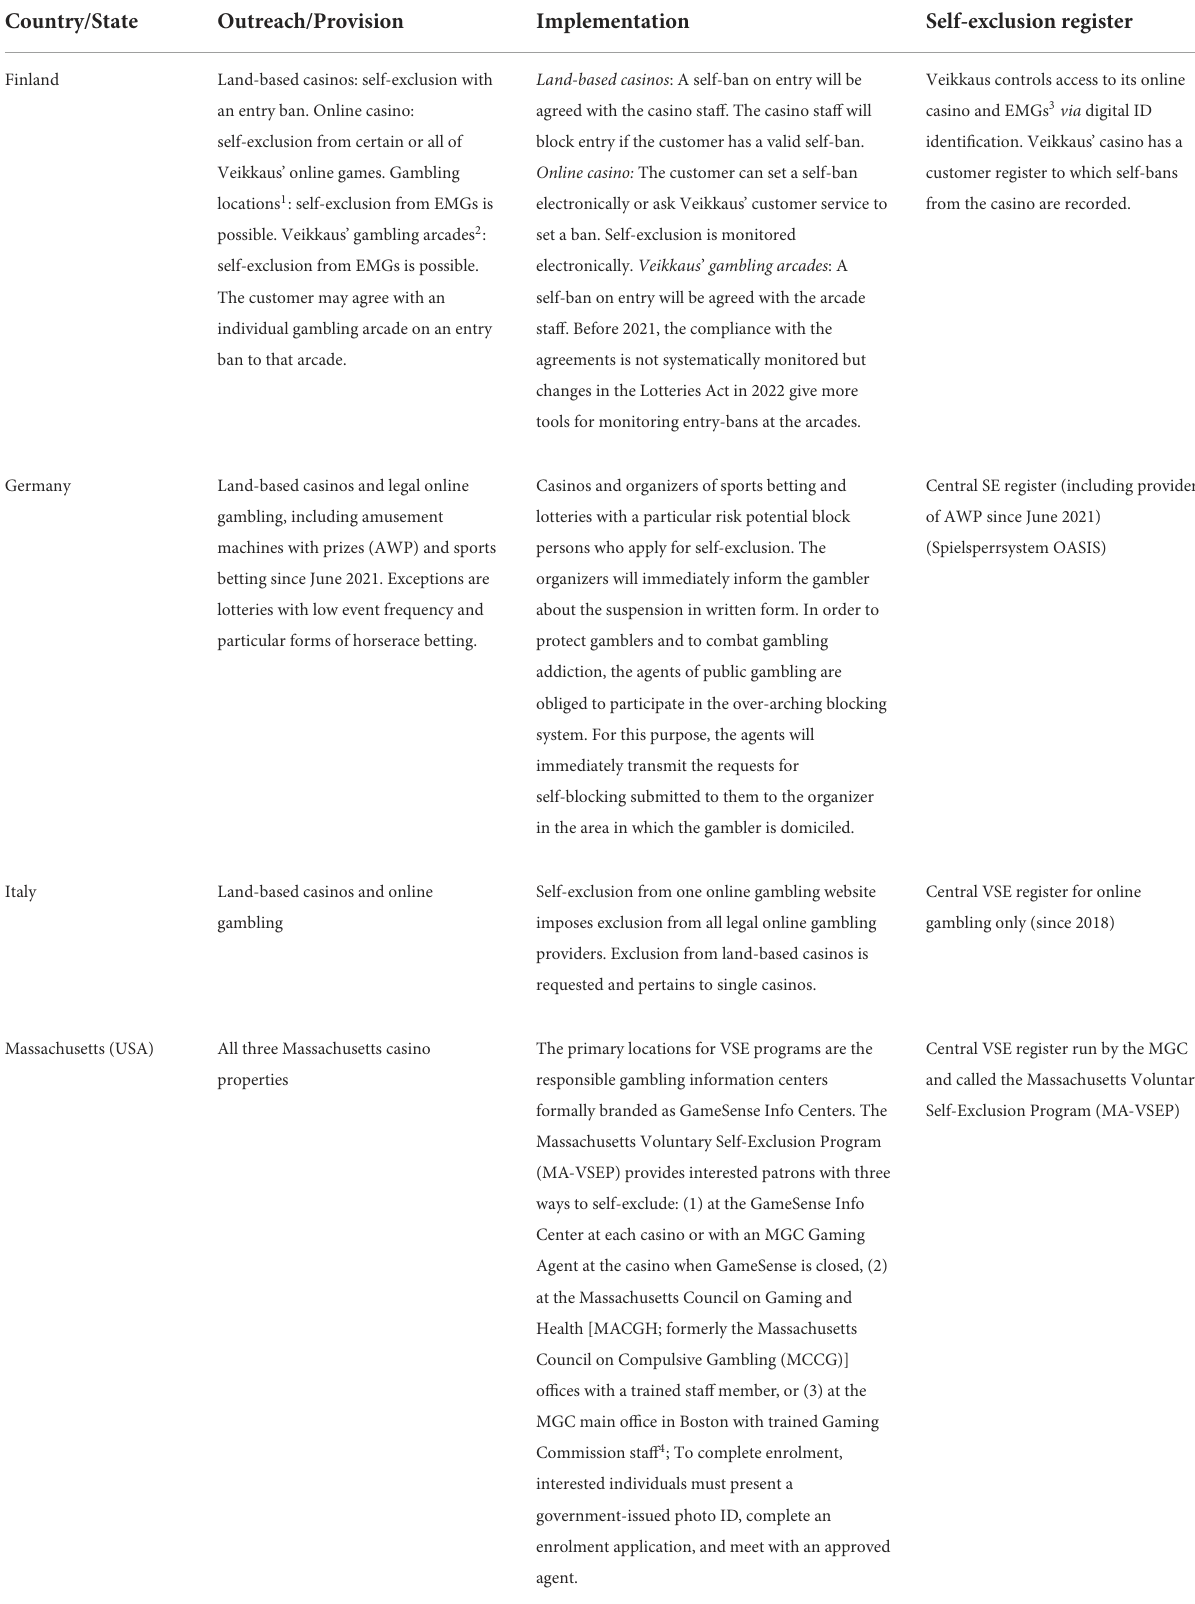
TABLE 2 Summary of voluntary self-exclusion regulations (outreach/provision, implementation, central register) by country/state.